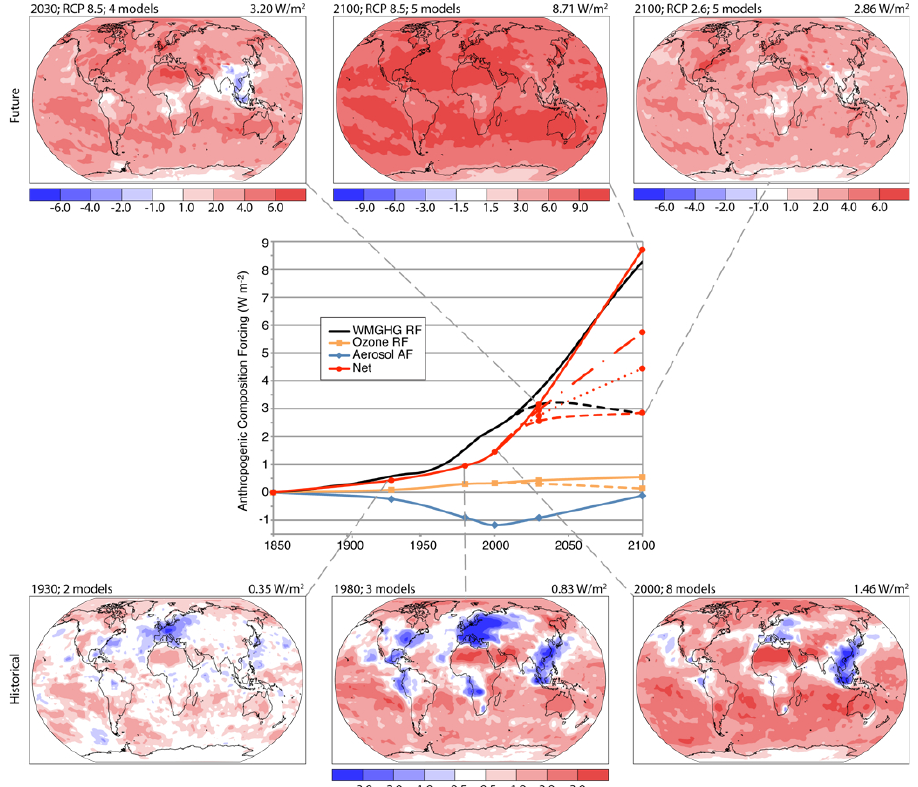
Fig. 21. Maps of total anthropogenic composition forcing and timeseries of global mean by component. Top row: maps of 2030 and 2100; bottom row: maps of 1930, 1980 and 2000 (note change in scale relative to top row); center panel: timeseries of global mean forcing with symbols indicating the times at which ACCMIP simulations were performed (solid lines are RCP8.5, dashed lines RCP2.6, dash-dot RCP6.0, and dotted RCP4.5). RCPs 2.6, 4.5 and 6.0 net forcings at 2100 are approximate values using aerosol ERF projected for RCP8.5.